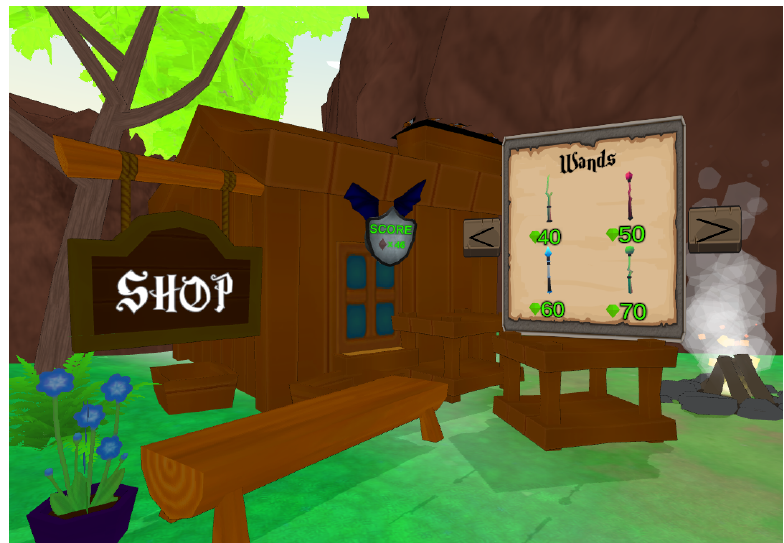
Figure 3. SoundFields virtual shop. Here, players are able to spend in-game currency to customise their